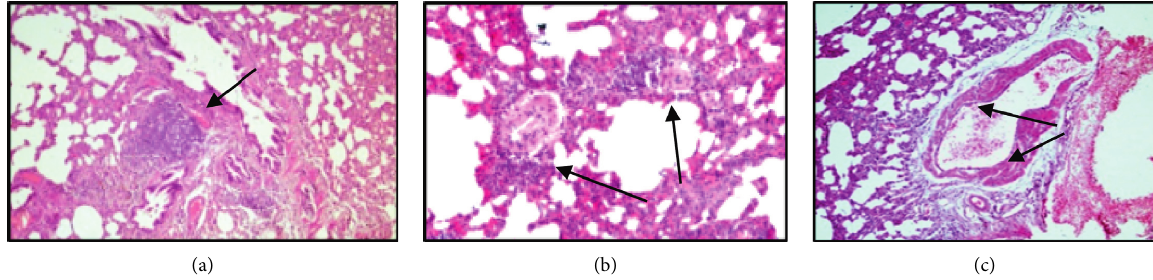
Figure 6: Histological structure of rat lungs 90days after a single irradiation at a dose of 6Gy in combination with exposure to coal dust every 4 days for 4hours: staining with hematoxylin and eosin. (a) Hyperplasia of peribronchial lymphoid tissue against the background of peribronchial and perivascular fibrosis of the lung stroma, zoom x180; (b) fibrosis of the arteriole wall in the lung interstitium, perivascular infiltration with lymphocytes, zoom x160; (c) hypertrophy of muscle-elastic fibers in the wall of the arterial vessel of the lung stroma, zoom